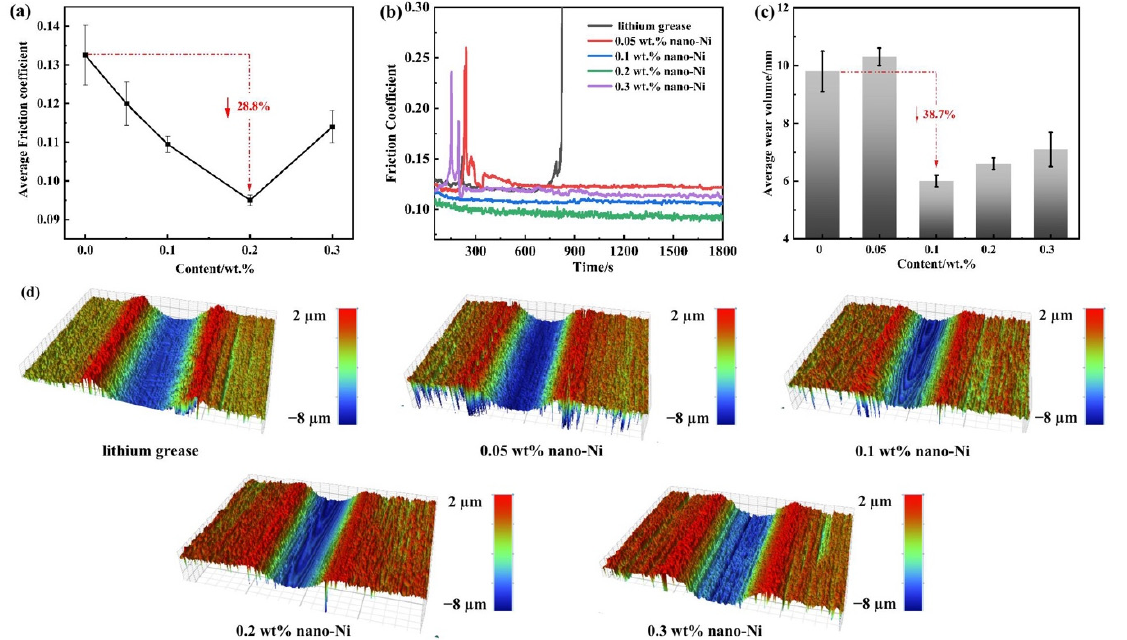
Figure 6. Tribological properties of the pure lithium grease and Ni-doped lithium greases under point-to-flat contact: ( a ) Average COF; ( b ) COF curves; ( c ) Average wear volume; ( d ) WLI morphologies of wear surface.